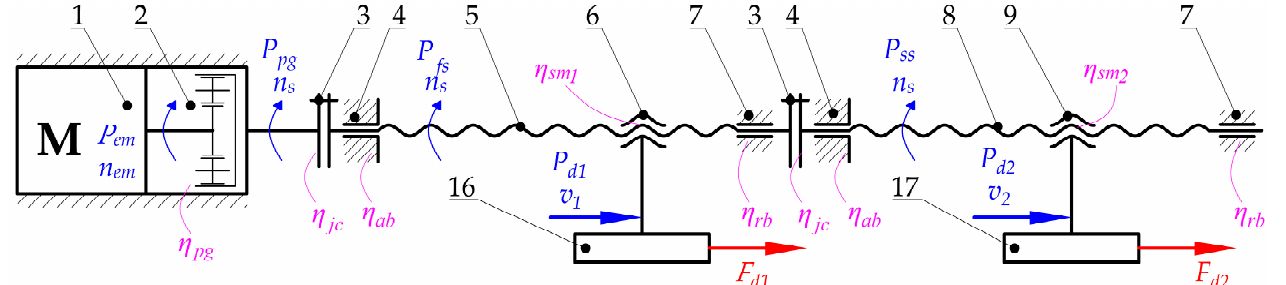
Figure 8. The kinematic structure of the main drive system of the automatic welding machine: 1—BLDC electric motor, 2—planetary gear, 3—jaw coupling with flexible insert, 4—angular bearing unit (fixing), 5—ball screw with pitch p 1 , 6—ball nut with pitch p 1 , 7—radial bearing unit (floating), 8—ball screw with pitch p 2 , 9—ball nut with pitch p 2 , 16—handle of the movable belt holder, 17—handle of the heating unit; P em —output power of the motor, P pg —output power of the planetary gear, P fs —power in the first ball screw, P ss —power in the second ball screw, P d 1 —power in the movable belt holder mechanism, P d 2 —power in heating unit mechanism, n em —rotational speed of the electric motor, n s —rotational speed of the screws, v 1 —linear velocity of the movable belt holder, v 2 —linear velocity of the heating unit, F d 1 —force which is needed to drive the movable belt holder, F d 2 —force which is needed to drive heating unit, η em —efficiency of planetary gear, η jc —efficiency of jaw coupling, η ab —efficiency of angular bearing, η rb —efficiency of radial bearing, η sm 1 —efficiency of first screw mechanism, η sm 2 —efficiency of second screw mechanism.